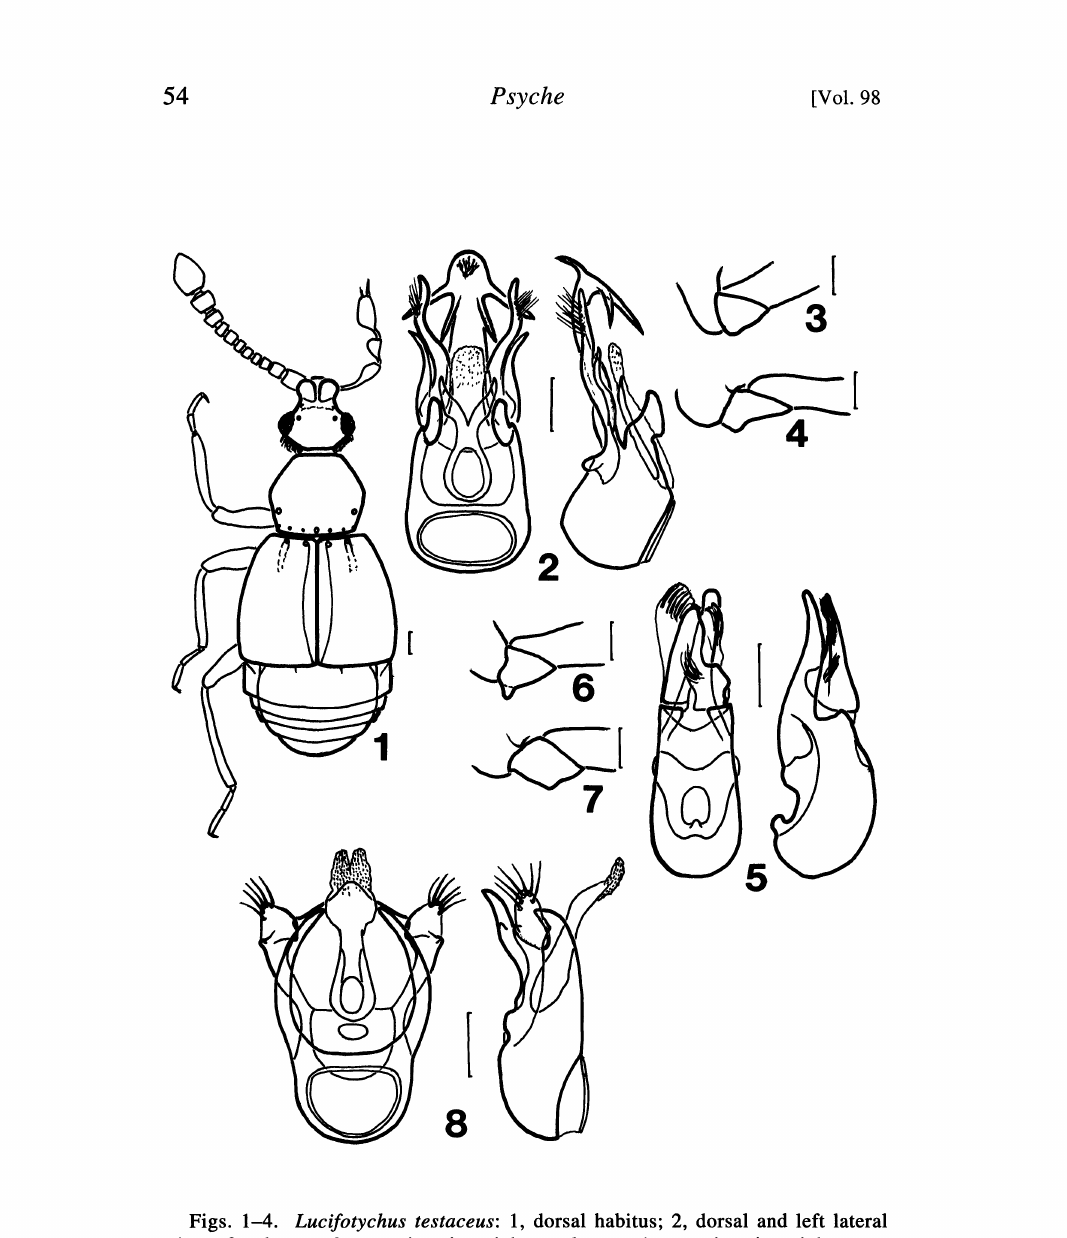
Figs. 1-4. Lucifotychus testaceus: 1, dorsal habitus; 2, dorsal and left lateral view of aedeagus; 3, posterior view right prochanter; 4, posterior view right meta- trochanter. Figs. 5-7. L. hirsutus: 5, dorsal and left lateral view aedeagus; 6, pos- terior view right protrochanter; 7, posterior view right metatrochanter. Fig. 8. L. quirsfeldi, dorsal and left lateral view